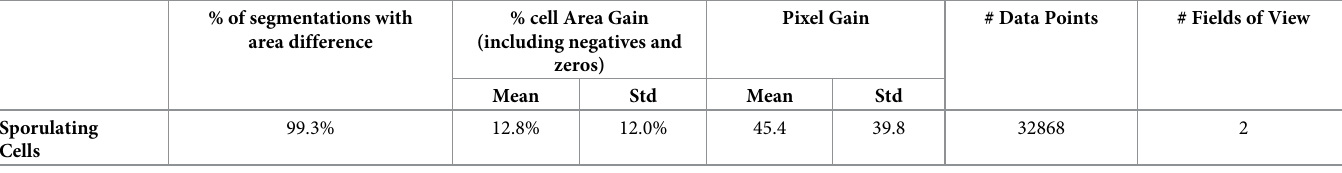
Table 5. Cell area with phase image and composite image.